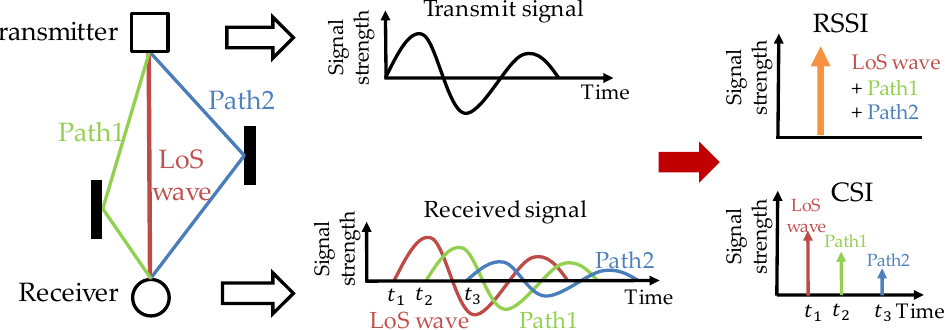
Figure 1. Signal propagation path and RSSI/CSI (received signal strength indicator/channel state information).